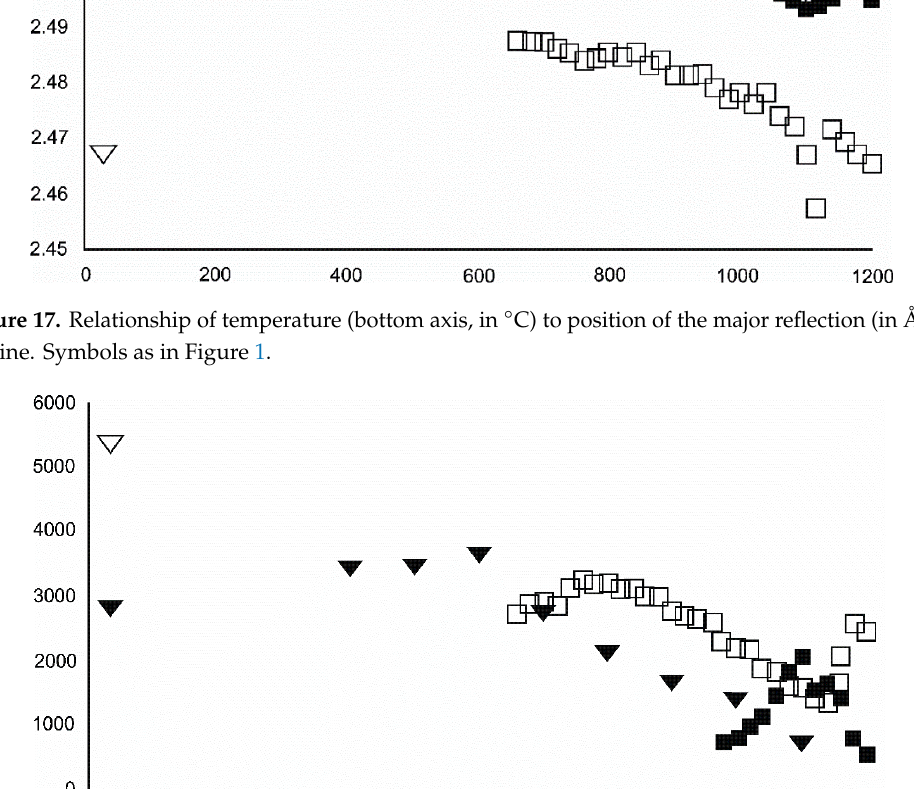
Figure 18. Relationship of temperature (bottom axis, in °C) to number of counts (left axis, arbitrary units) for olivine. Symbols as in Figure 16.